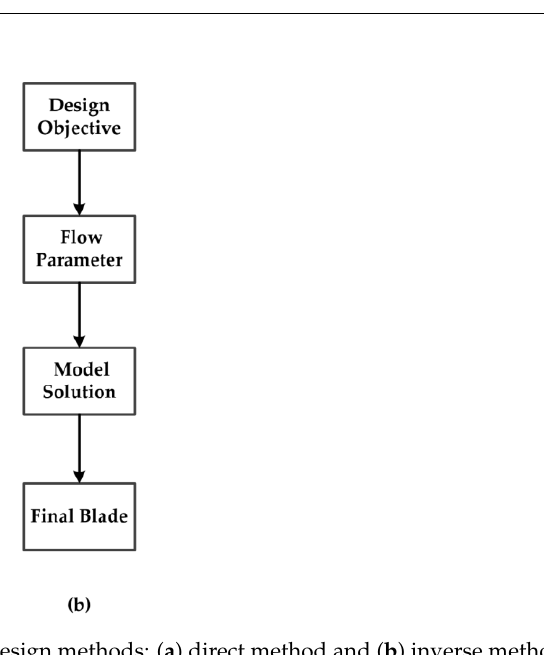
19 of 34 Figure 18. Duct types: ( a ) accelerating duct and ( b ) decelerating duct. Figure 19. Flow-field pressure contour of the accelerating duct ( a ) and decelerating duct ( b ). The above descriptions are design principles and design guidelines for each im- portant component, followed by an overview of the main design methods for the pump- jet blade, which is mainly composed of the direct method and the inverse design method, with both of the design procedures shown in Figure 20. The process shown in Figure 20a, the direct method, which is one of the traditional blade design methods, uses the known flow conditions to obtain the initial blades. The optimization for the final model on the basis of the hydrodynamic performance parameters is calculated by CFD method or ex-